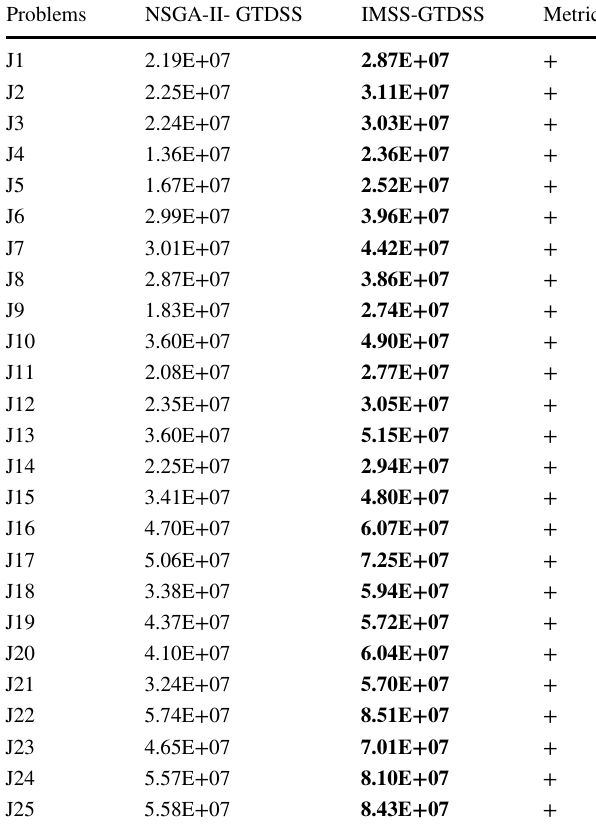
Table 3 The HV metrics obtained by NSGA-II-GTDSS and IMSS- GTDSS and the result of the